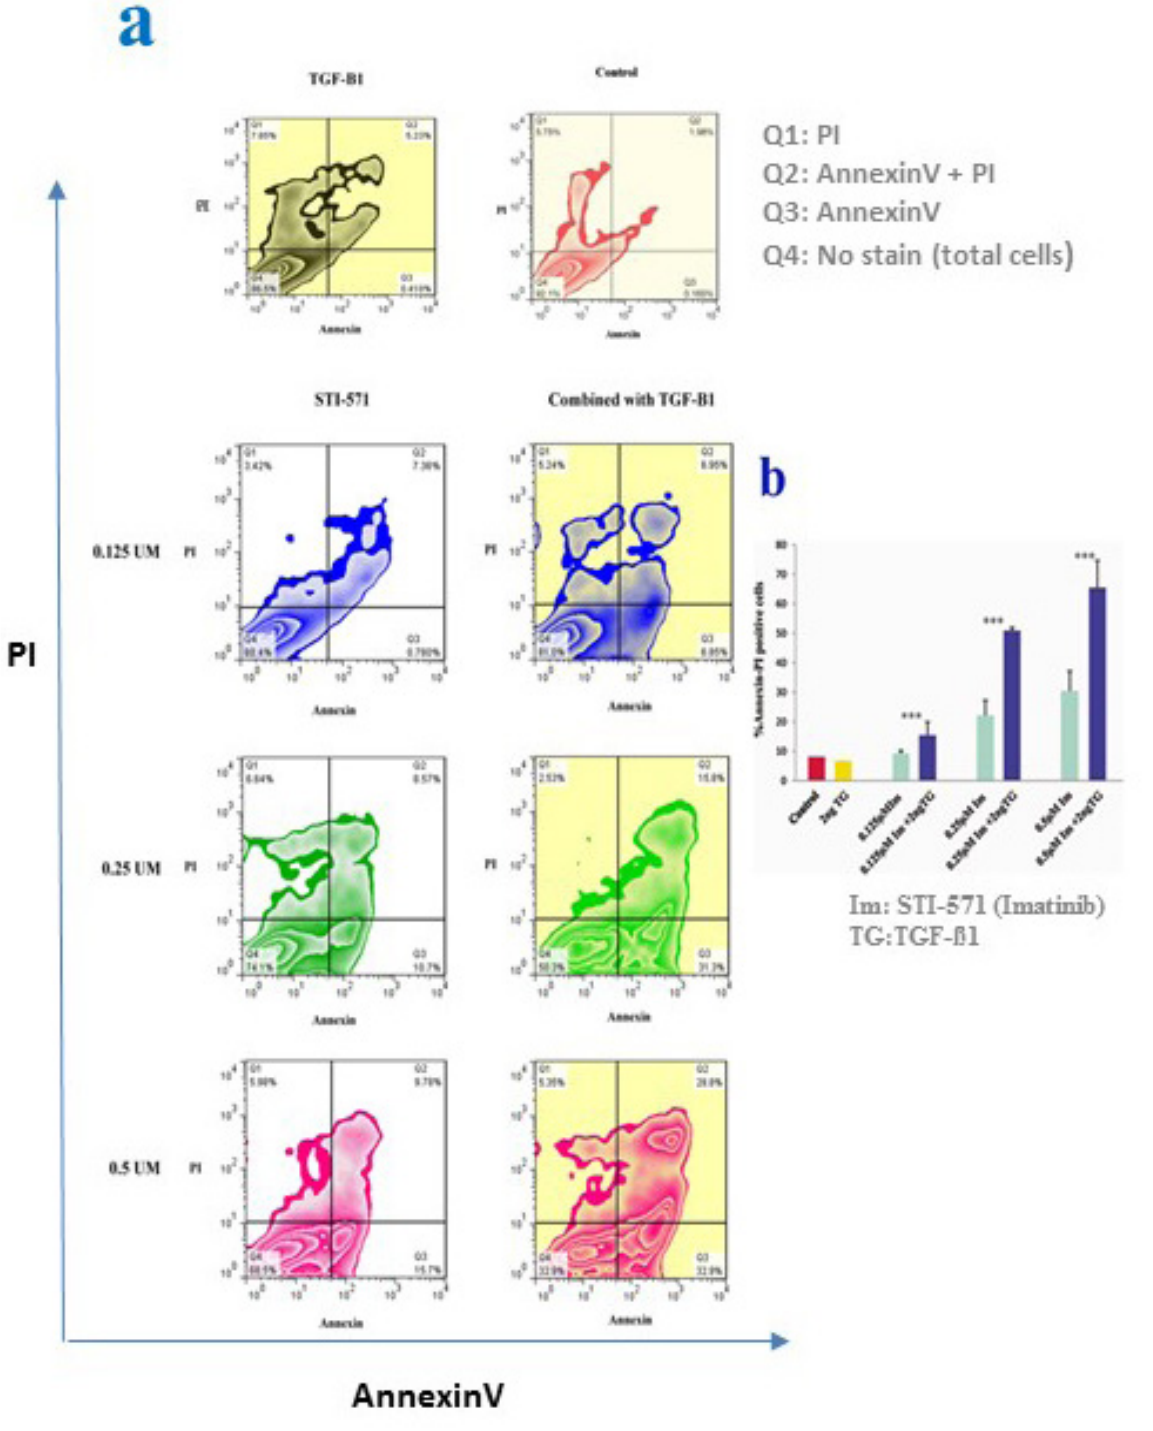
Figure 1: a) Histogram of Annexin-PI-positive K562 cells treated with 2 ng/mL of TGF-β1 and different concentrations of STI-571, individually or in combination, for 48 hours. The graph on the left represents different concentrations of STI-571, while the one on the right represents their combination. b) Graph of Annexin-PI-positive K562 cells treated with 2 ng/mL of TGF-β1 and different concentrations of STI-571, individually or in combination, for 48 hours. The number of apoptotic cells gradually increased with increasing STI-571 concentrations and with the combination therapy. The data are represented as the mean ± SD. *** indicates P <